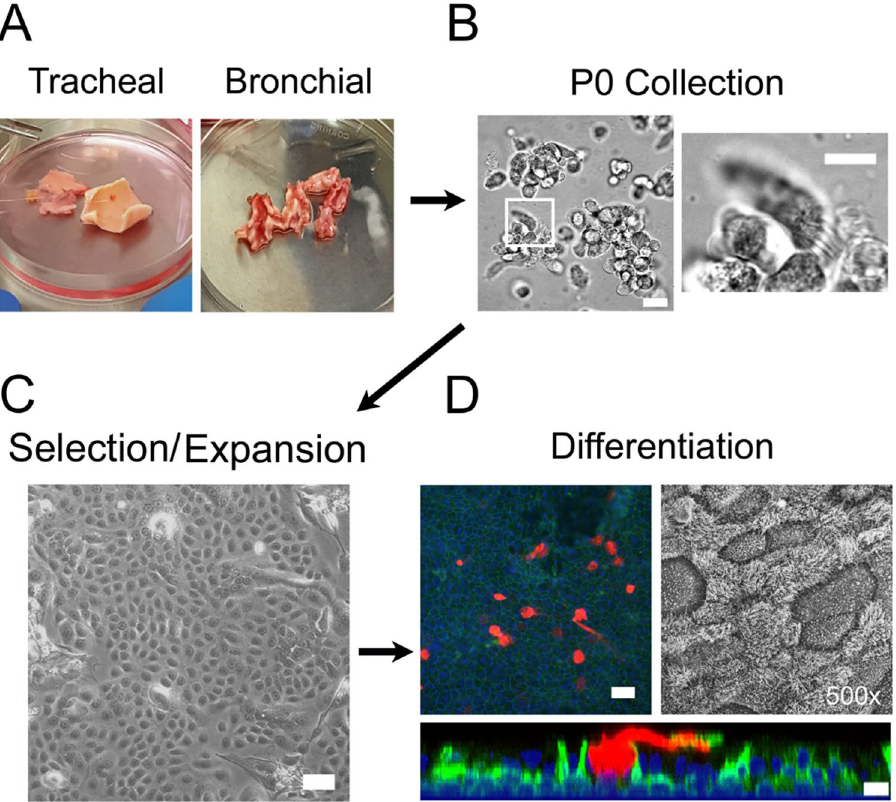
Figure 1. Workflow for isolation of cells from distinct anatomic regions of the airway tree. ( A ) Examples of healthy tracheal and bronchial tissue isolates are shown based on donor tissue color, shape, and rigidity as markers for tissue health. ( B ) Freshly isolated primary (passage 0; P0) cells isolated from nasal or lung tissue contain a mixture of cells, including ciliated (inset) and non-ciliated cells. Bars, 20 μm (left) and 10 μm (right). ( C ) Basal nasal or airway epithelial cells are selected and expanded using CRC conditions, as imaged by phase contrast microscopy. Bar, 10 μm. ( D ) Basal airway or nasal cells cultured in E-ALI containing normal glucose properly differentiate as determined by immunofluorescence confocal microscopy using markers for mucus secretion (Muc5AC, red), basal cells (KRT5, green), nuclei (blue, DAPI) and by scanning electron microscopy. Bars, 20 μm (top and middle) and 10 μm (bottom).